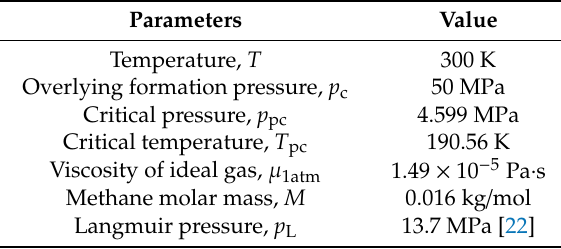
Table 1. Basic parameters for model validation.